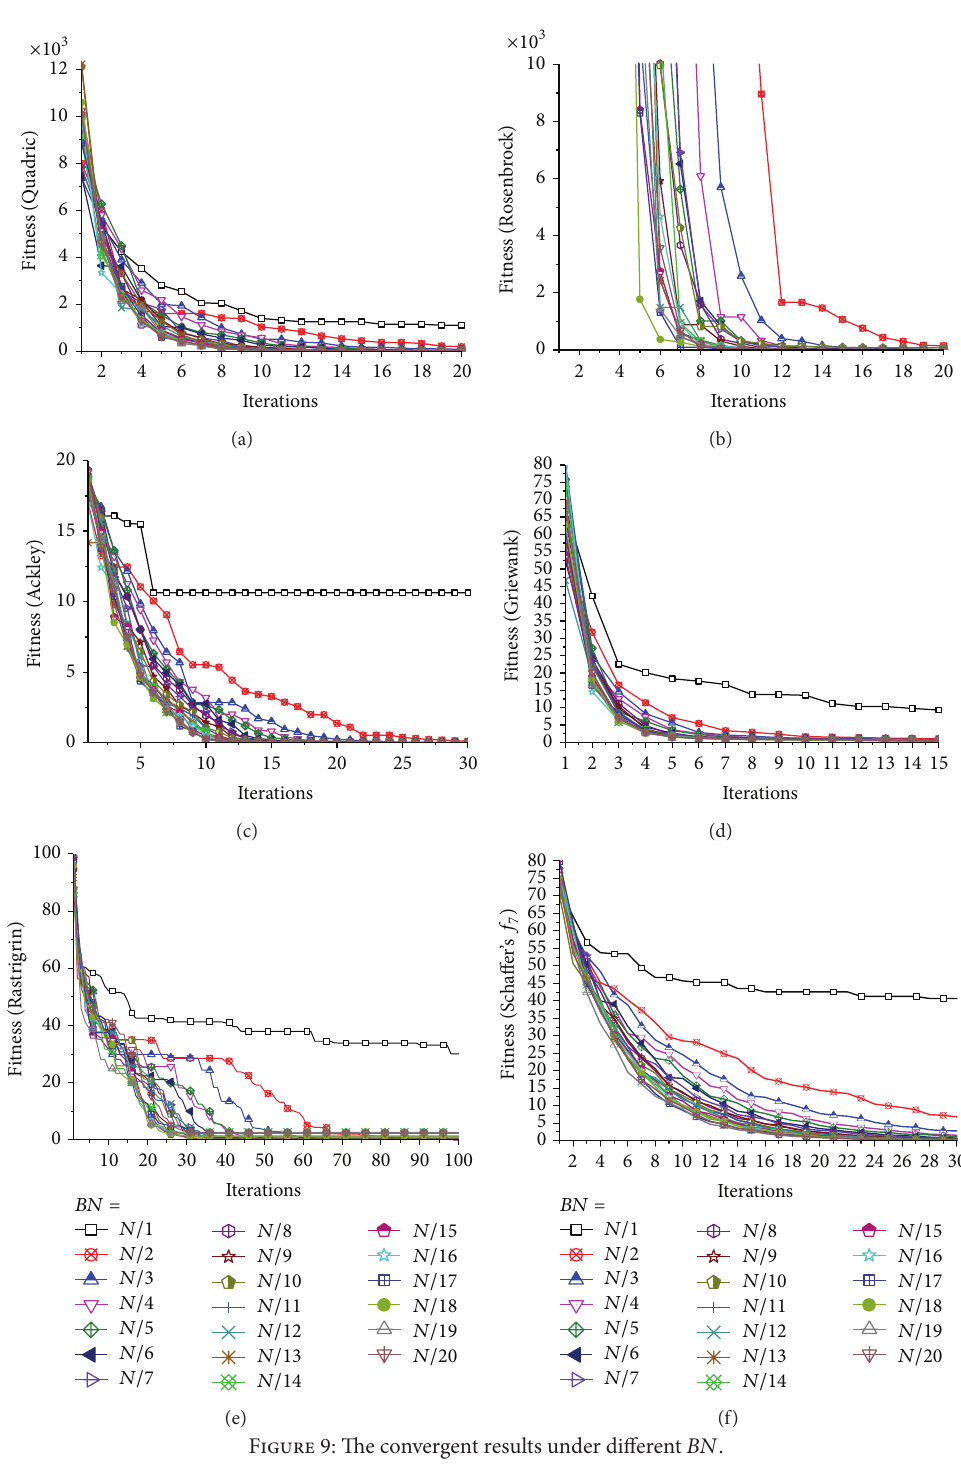
Figure 9: The convergent results under different 𝐵𝑁